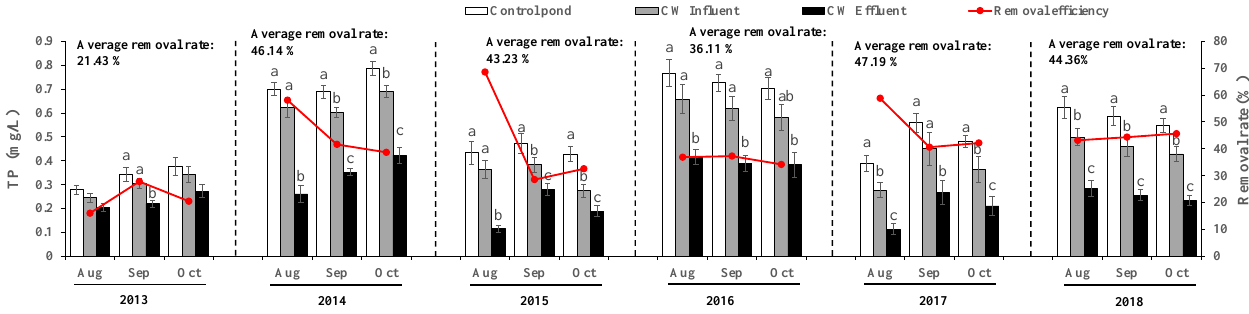
Figure 2. Concentration of TP in water samples collected from the control pond and the inlet and outlet of CW, and the removal efficiency during the monitoring period. The value is expressed as mean ± SE ( n = 6), and different small letters in bar graphs indicate significant differences ( p < 0.05) among the control pond, CW influent and CW effluent.